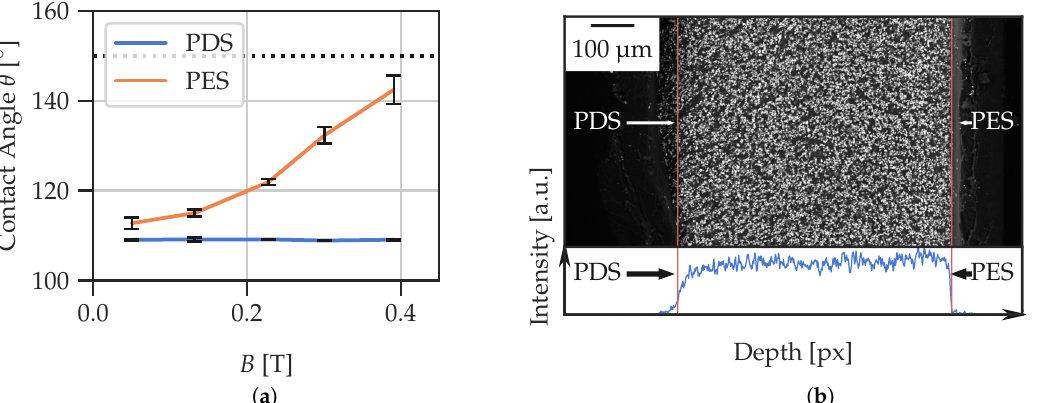
Figure A1. Example of differences between PDS and PES. ( a ) Comparison of the effect of magnetic field on CA for the PDS and the PES of an exemplary MAE sample. ( b ) SEM image of the cross-section of an MAE sample.